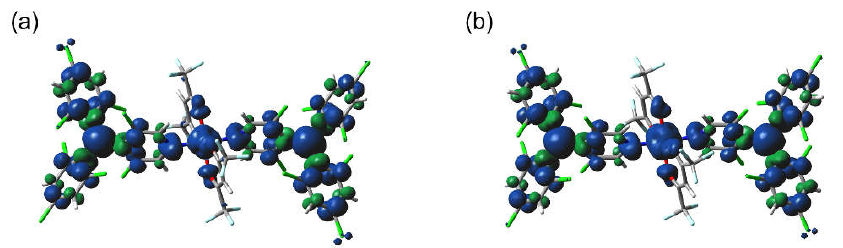
Figure 4. Spin-density distribution of ( a ) [Ni II (hfac) 2 (PyBTM) 2 ] and ( b ) [Co II (hfac) 2 (PyBTM) 2 ] calculated using DFT: uB3LYP/6-31G(d) for C, H, O, Cl, F, and N; LANL2DZ for Ni and Co. One of the two crystallographically independent molecules is shown in each complex.